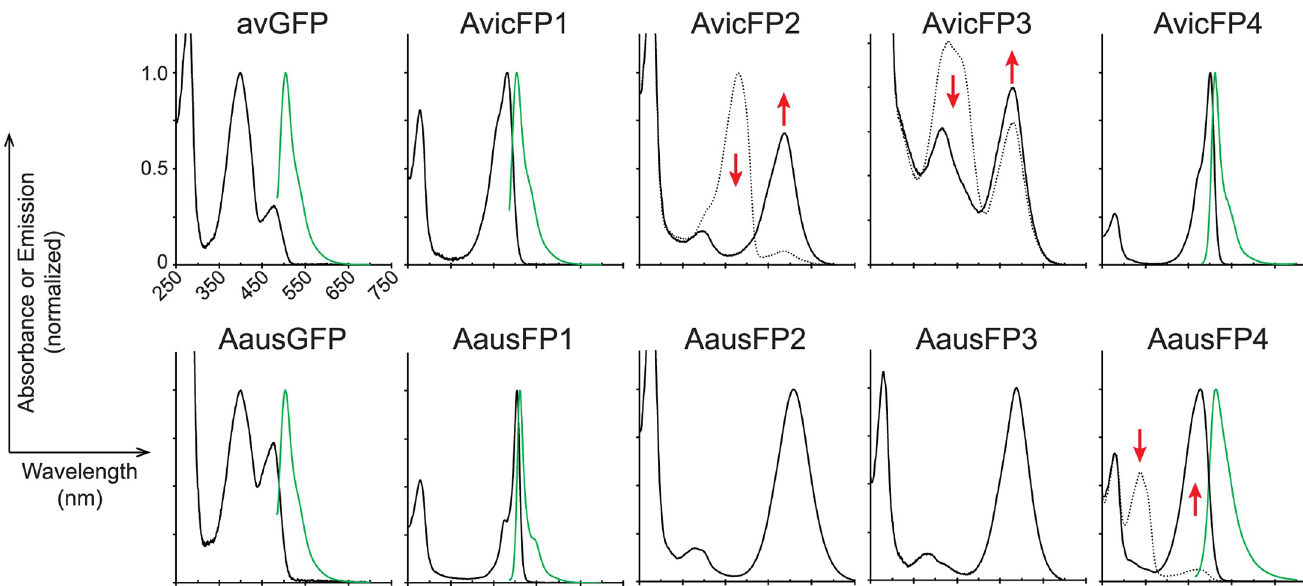
Fig 2. Absorbance and emission spectra (where measurable) for FP homologs in this study. Proteins from each species were designated AvicFP or AausFP and numbered in order of discovery, with chromoproteins retaining the “FP” nomenclature for consistency. For photoswitchable and photoconvertible proteins, pre- illumination absorbance spectra are shown as dotted lines, and post-illumination absorbance spectra as solid lines. Emission spectra are shown as green solid lines. The emission spectra for AvicFP2 and AvicFP3 were measured using 460-nm excitation prior to photoconversion. The emission spectrum of AausFP4 was measured using 440-nm excitation after photoswitching to the blue-absorbing state. Red arrows indicate peaks that increase or decrease upon photoconversion or switching. For ease of display, spectra are normalized to the maximum visible absorbance for non-photoactive proteins, and to the pre- (for AvicFP2) or post-illumination (for AvicFP3 and AausFP4) maximum for photoactive proteins. All plots share the same x -axis scale as shown for AausGFP. The data underlying this figure may be found at FPbase (https://www.fpbase.org). FP, fluorescent protein.